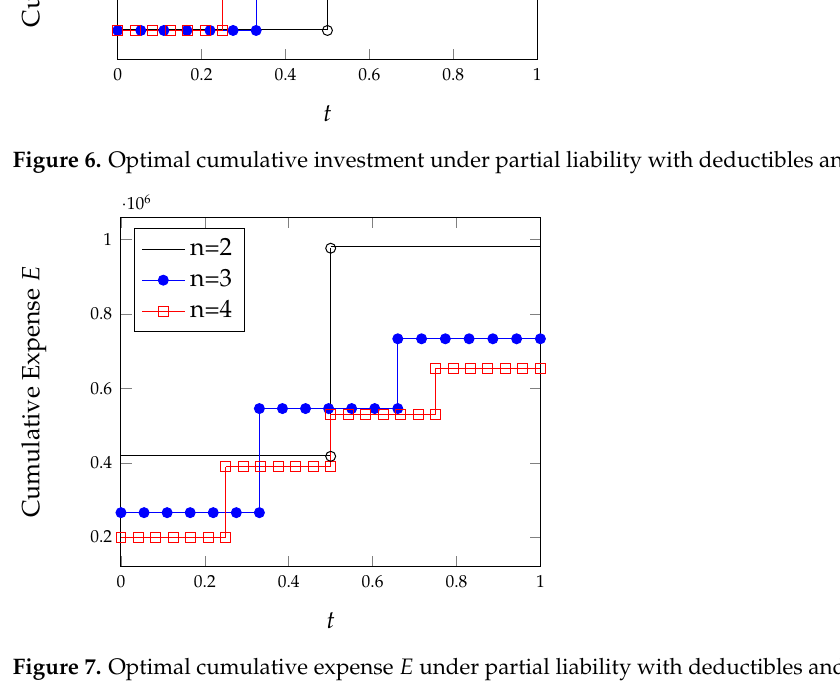
Figure 7. Optimal cumulative expense E under partial liability with deductibles and GL1 model. Similar results are found for the GL2 model. Here, we do not comment on those results, but simply show the pertaining curves in Figures